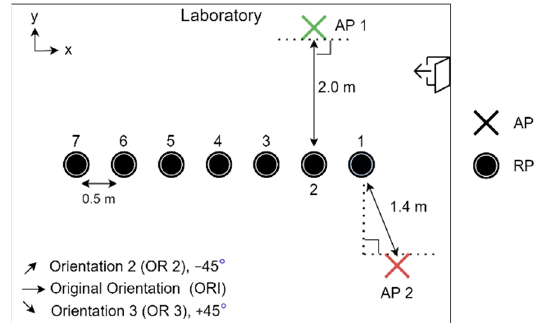
Figure 3. Relative locations of RPs and APs in experimental setup.